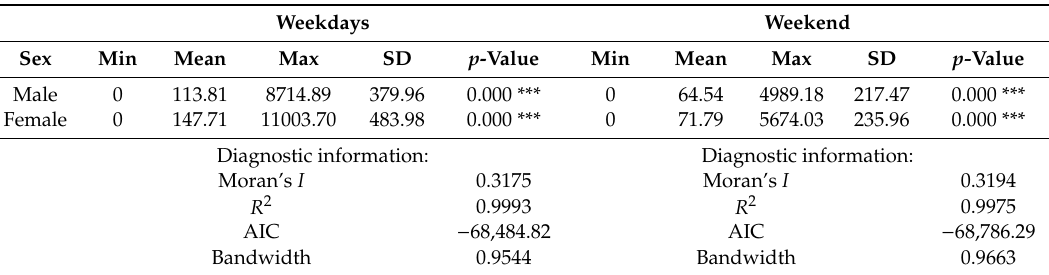
Table 3. Estimated geographically weighted regression (GWR) parameters by men and women during weekdays and